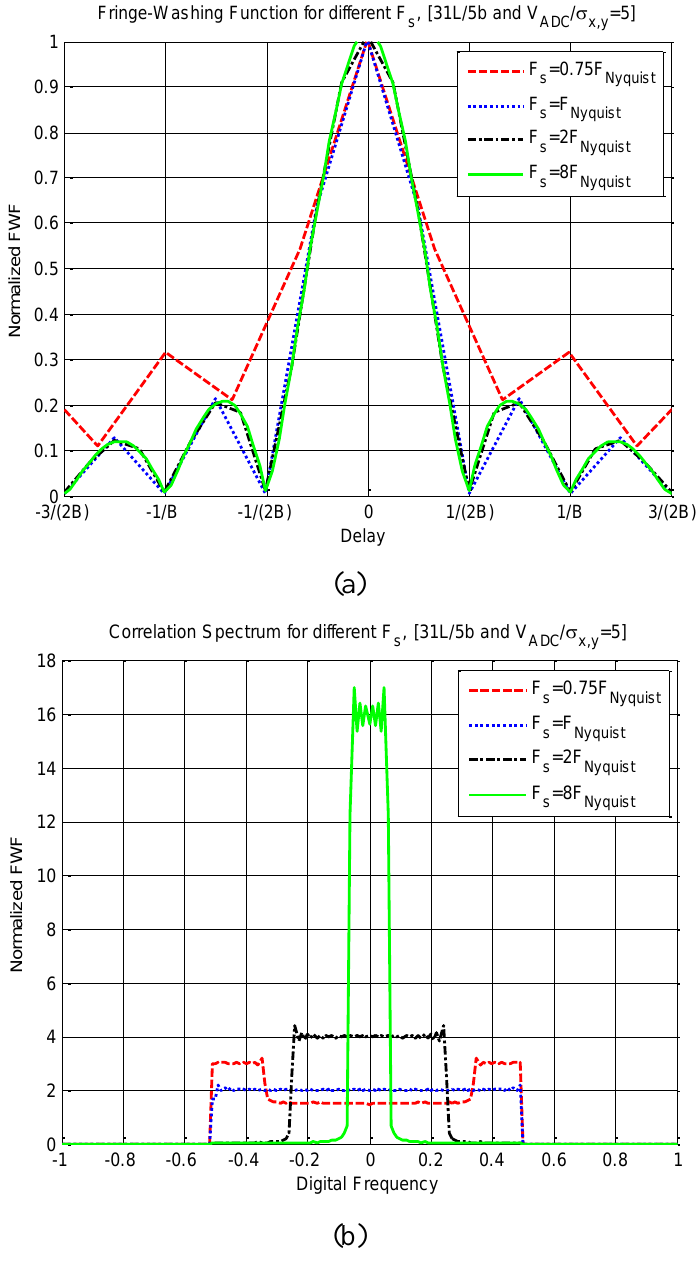
Figure 10. Impact on the quantized correlation of different sampling frequencies. For 31 quantization levels, a bandwidth 2B, and V for the fringe-washing function, and (b) shows the effect on their